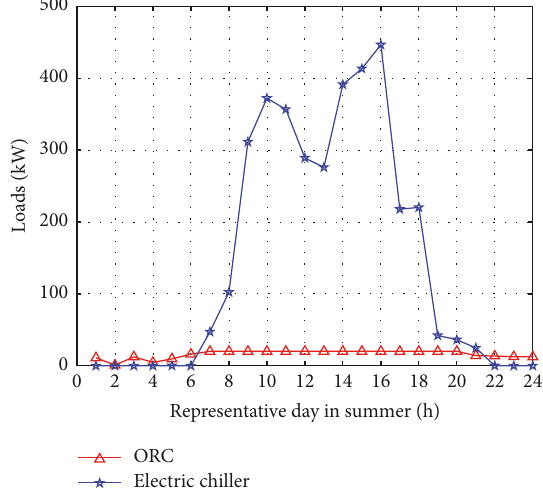
Figure 12: Hourly outputs of the EC and ORC in a summer